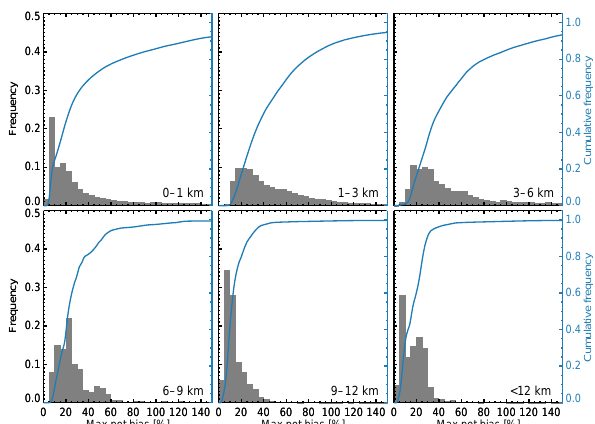
Figure 9. Histogram (gray) and cumulative histogram (blue) of the maximum potential biases for CloudSat-driven end-to-end profile water vapor retrievals for each of the CloudSat measurements avail- able from 15 January 2007.